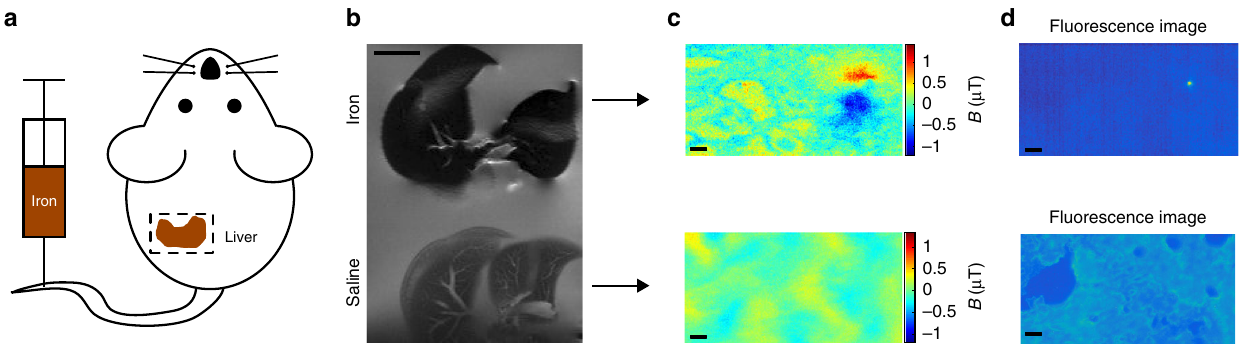
Fig. 3 Magnetometry of histological samples. a Diagram of mouse model of iron overload, prepared by injecting 10 mg kg − 1 of 900 nm iron oxide nanoparticles into the tail vein. b 7T T 2 -weighted MR image of fi xed, excised mouse livers from mice injected with IONs or saline. c NV magnetic fi eld maps of 10 µ m liver sections obtained from the mice in b . d Fluorescence images of the tissue samples in c . Fluorescence images were taken with autogain to reduce the necessary exposure time, resulting in the visibility of the auto fl uorescence of the tissue in the saline control. Magnetometry scans were taken with a fi xed gain. This experiment was repeated a total of three times, with data from two additional experiments shown in Supplementary Fig. 6. Scale bars in b and c – d are 5 mm and 10 µ m,